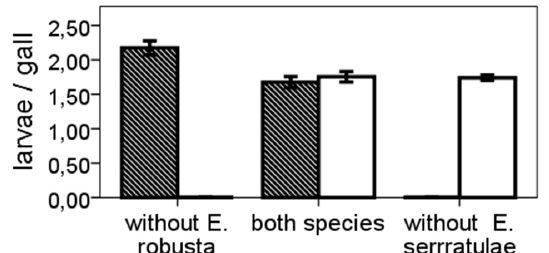
Figure 5. Asymmetric interaction between the E. serratulae (black) and E. robusta (white): Average numbers of E. serratulae /gall without E. robusta (381 galls); E. serratulae together with E. robusta (324 galls); E. robusta without E. serratulae (2454 galls).